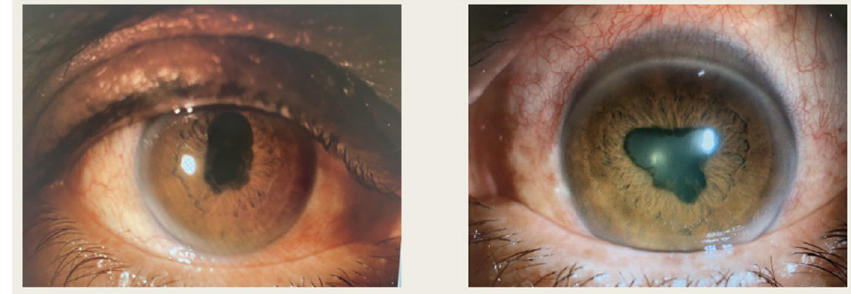
Fig. 1 Anterior segment photographs of the right and left eyes at presentation